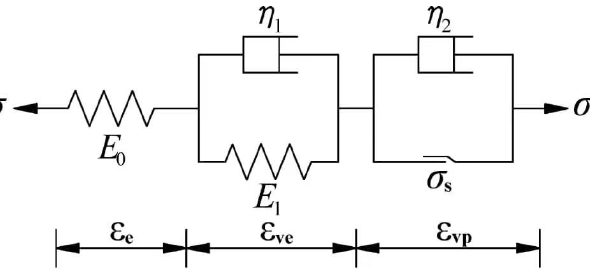
Figure 8. Classical Nishihara model (after Liu et al. [20], Copyright©2022, with permission from the publisher, License No. 5333750232228).